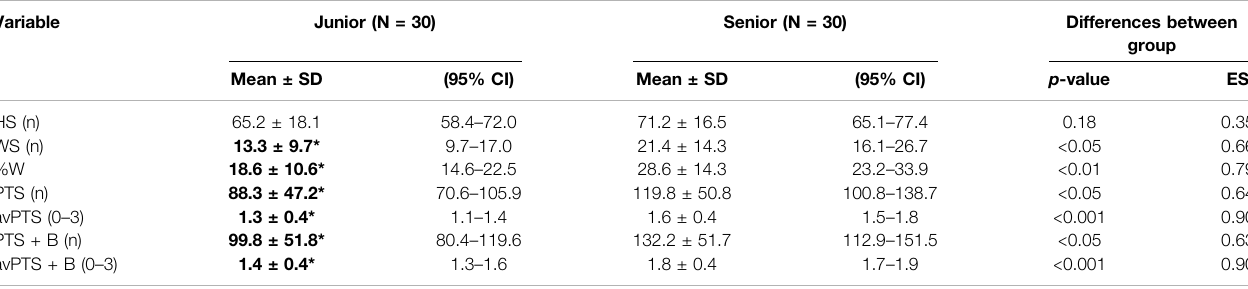
TABLE 5 | Mean ± standard deviation and 95% CI of the sport levels indicators of the riders, as determined by the scores obtained during all heats in the league season. Variable Junior (N = 30) Senior (N = 30) Differences between